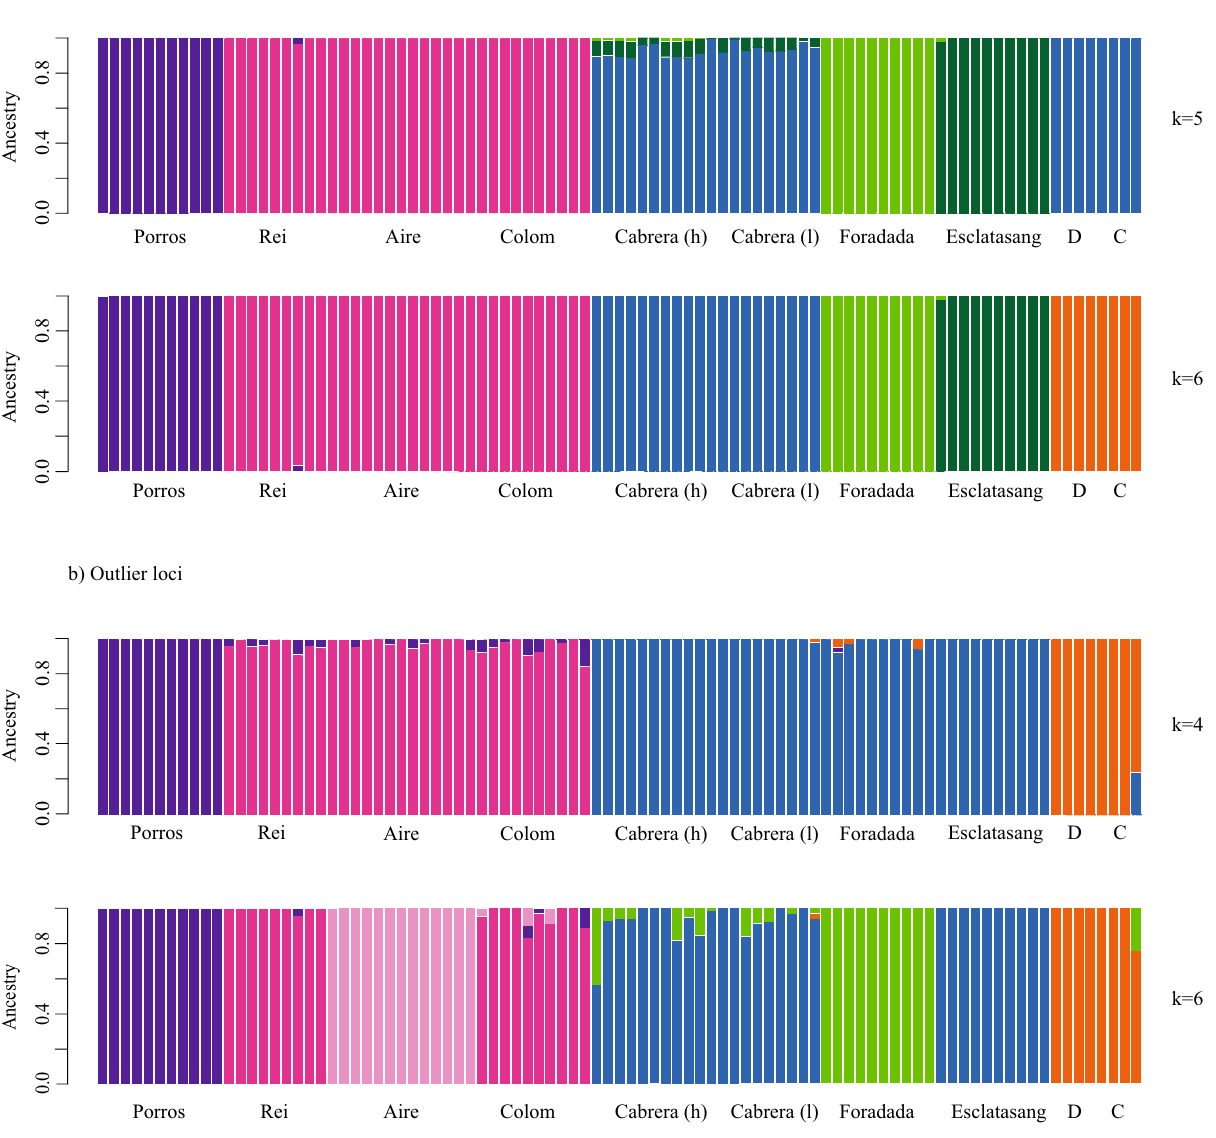
Figure 2. Admixture analysis results using all SNPs dataset ( a ) at K = 5 and K = 6, and only outlier loci ( b ) at K = 4 and K = 6. D Dragonera, C